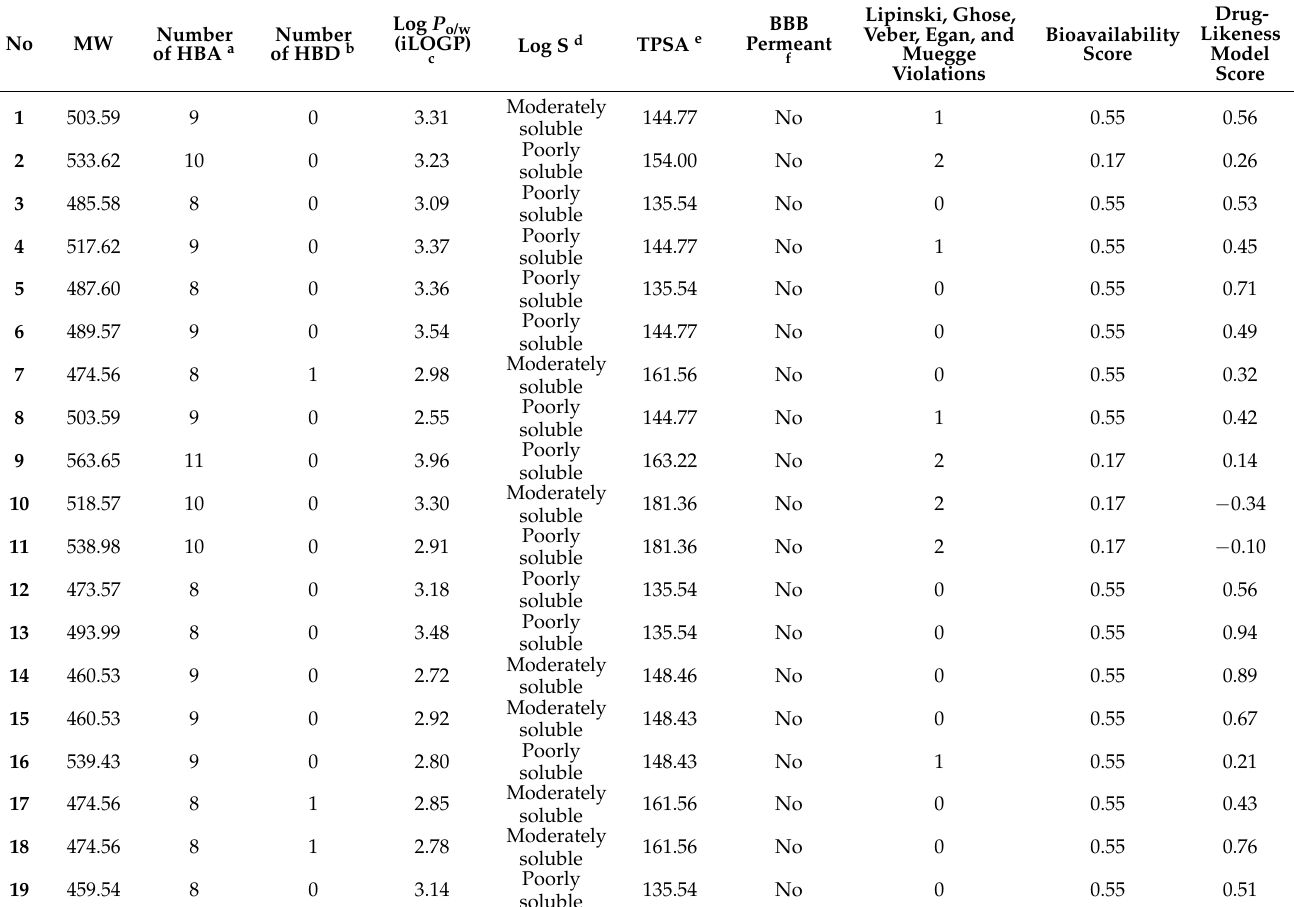
Table 8. Drug likeness predictions and Physicochemical-Pharmacokinetic/ADME properties of tested